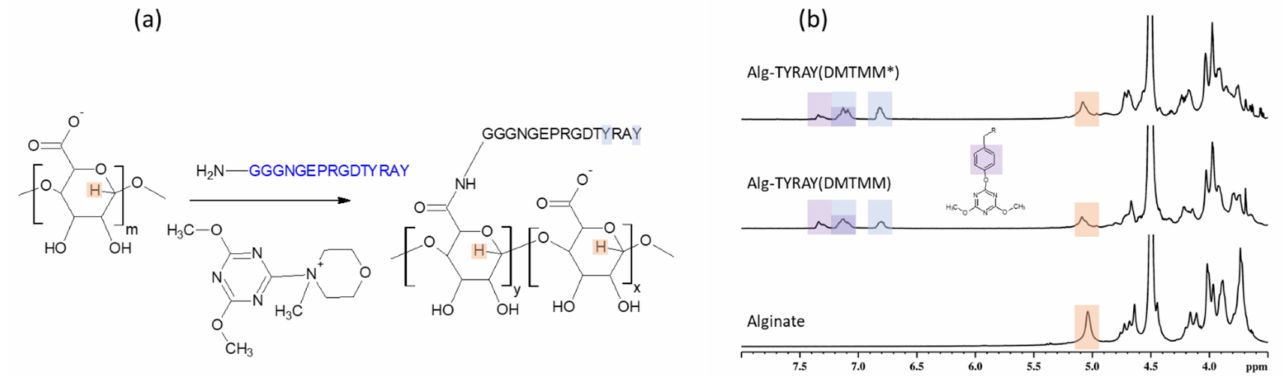
Figure 2. Peptide conjugation to alginate with help of DMTMM coupling. ( a ) Scheme of the reaction; ( b ) 1 H NMR spectrum of sodium alginate measured in D 2 O at 50 ◦ C (bottom); 1 H NMR spectrum of Alg-TYRAY(DMTMM) measured in D 2 O at 50 ◦ C (middle); 1 H NMR spectrum of Alg-TYRAY(DMTMM*) measured in D 2 O at 50 ◦ C (top). Specific signals proving the modification are marked with